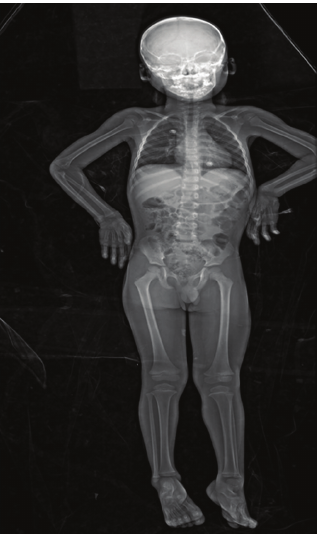
Figure 5: Paediatric full-body X-ray image showing superior imaging of the major